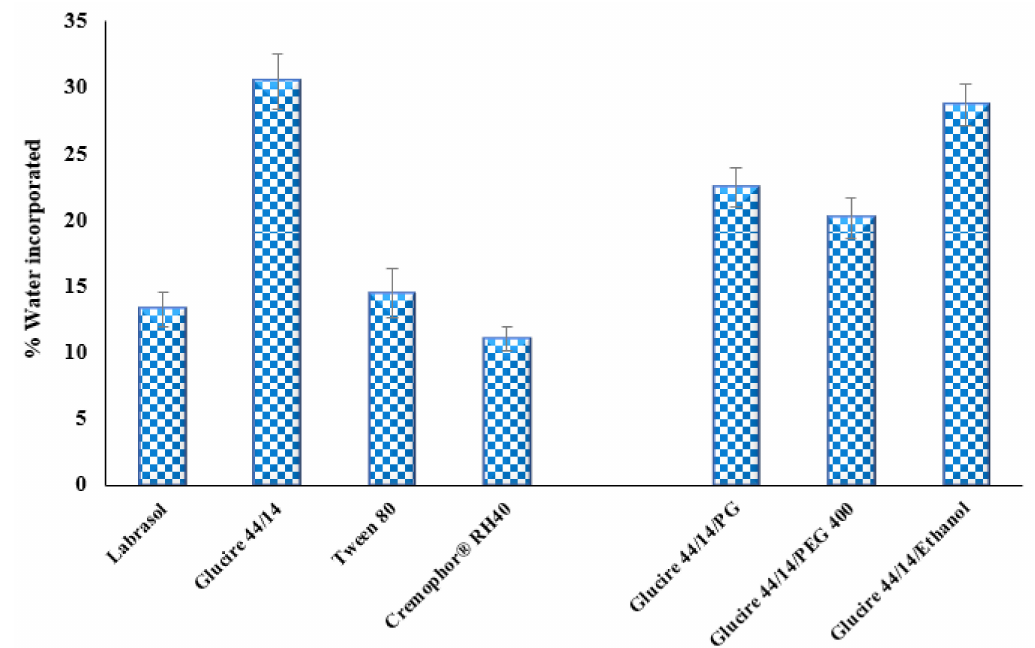
Figure 3. Percentage of water incorporated into mixtures of Capryol™ 90 and different surfactants and surfac- tant/cosurfactant mixtures (mean ± SD, n = 3).